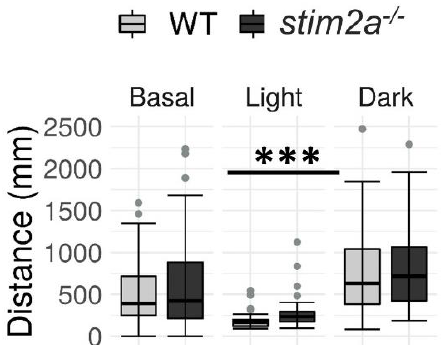
Figure 6. The stim2a − / − larvae reacted to changes in the light and exhibited hyperactivity during the low activity phase in the visual–motor response test. Activity was recorded during a 30 min period that consisted of a baseline phase (basal, 0% light illumination), low activity phase (light; 70% light illumination), and high activity phase (dark; 0% light illumination). Box plots show the distance traveled (in millimeters) during the respective phase. *** p < 0.001 (Wilcoxon rank-sum test). n = 53 WT larvae. n = 52 stim2a −/− larvae. Number of experiments: 6.